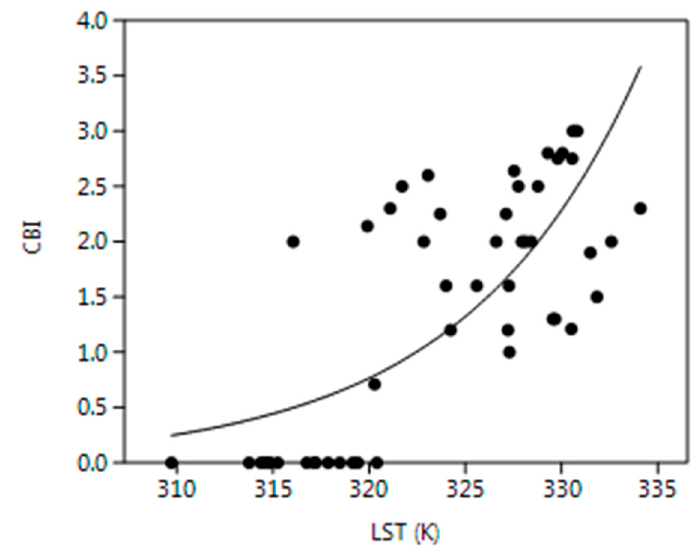
Figure 3. Relationship between LST values (K) and soil burn severity measured in CBI (Composite Burn Index) units. Table 6. Generalised linear model (GLM) results for changes in soil characteristics (response variable) in relation to LST values (predictor variable). Degrees of freedom (Df). Significant p -values are in bold face. Grubbs signification (G).